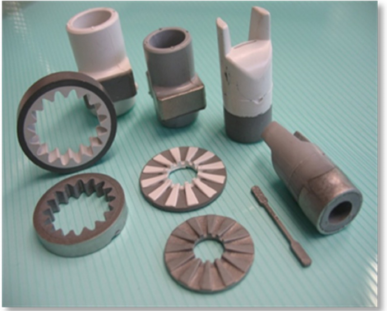
Figure 1. Metal–ceramic composites manufactured by two-component ceramic injection molding (2C-CIM) (manufactured by group “Shaping” at FhG-IKTS).